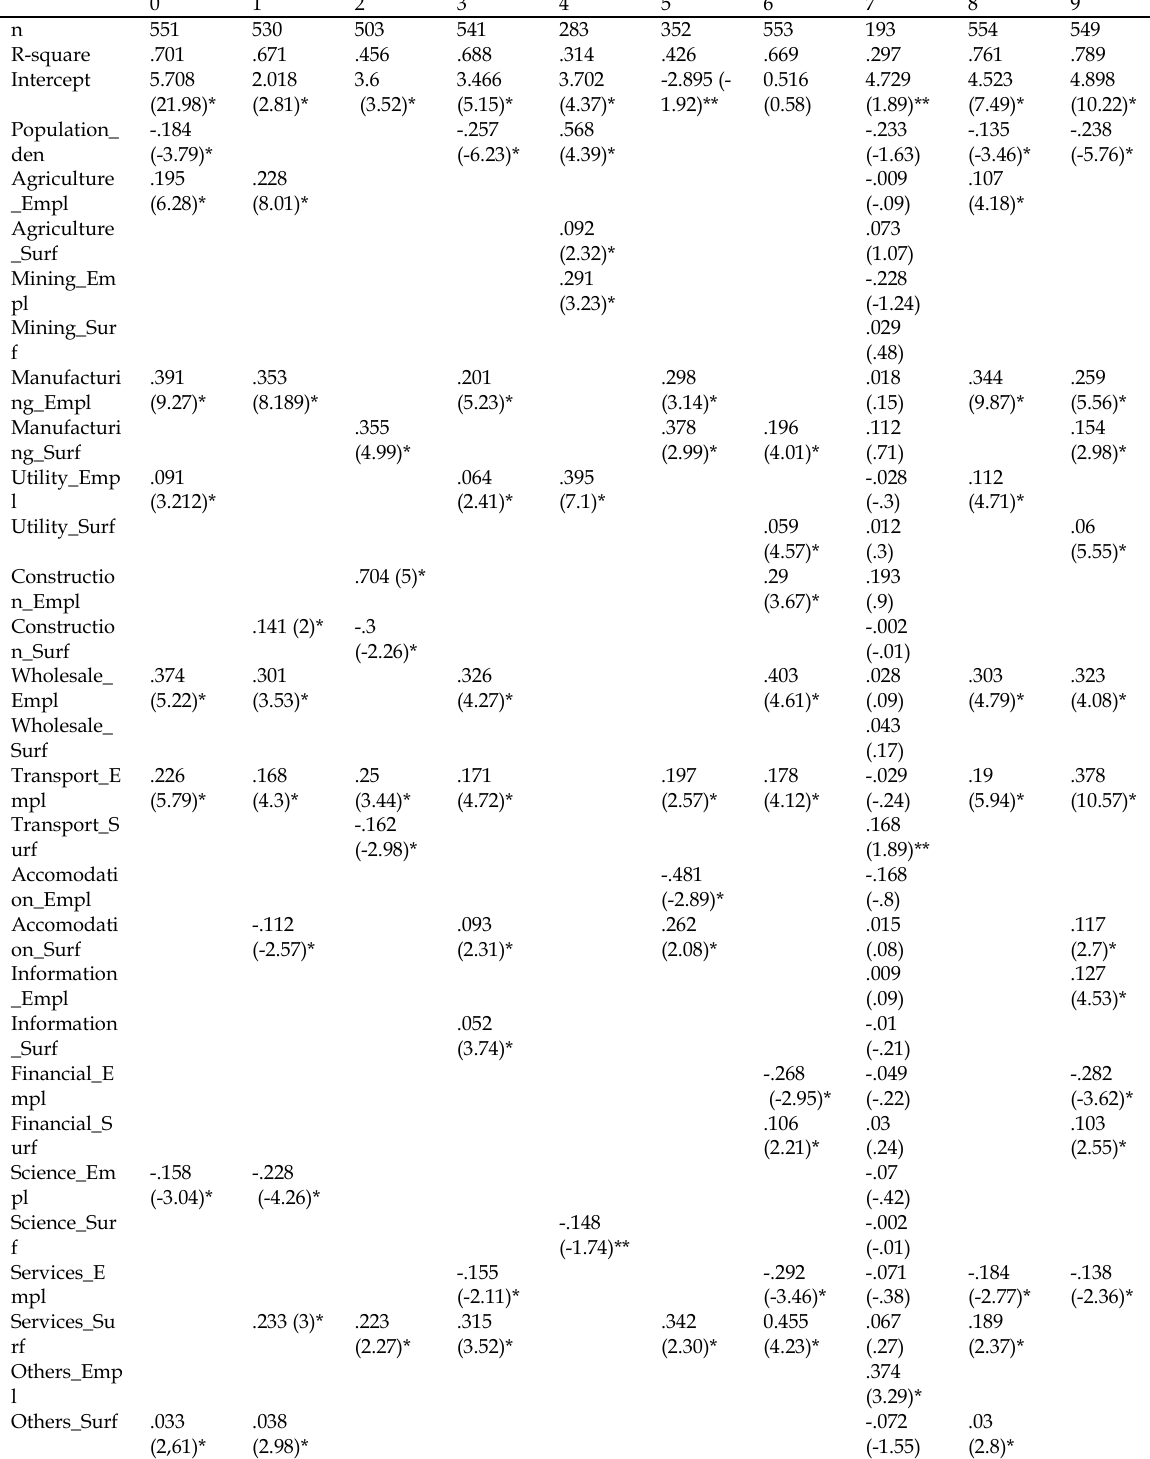
Table 6. Freight attraction